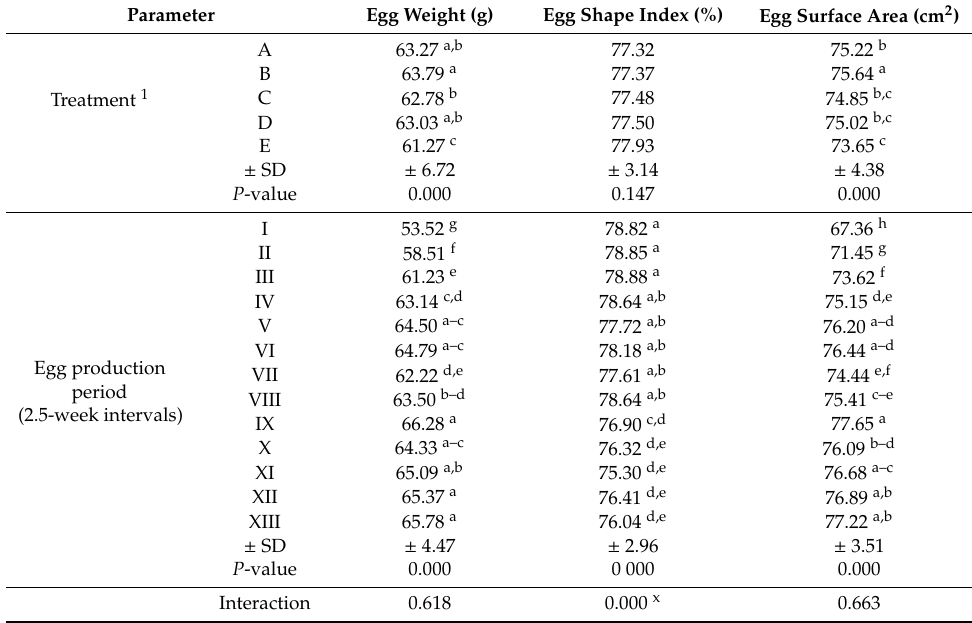
Table 3. Egg weight, egg shape index and egg surface area (means ± SD *).